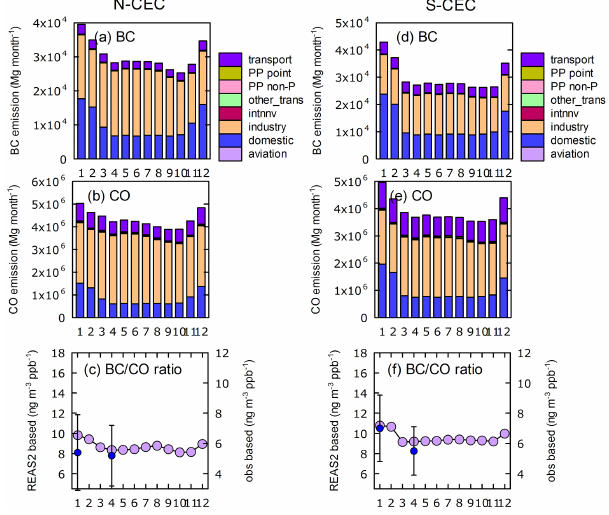
Figure 7. Monthly BC emissions from individual sectors for BC and CO and their ratios (purple) for (a–c) N-CEC (Beijing, Tianjin, Hebei, Shandong, and Shanxi) and (d–f) S-CEC (Shanghai, Anhui, Henan, Jiangsu, and Hubei) from REAS2 (Kurokawa et al., 2013). PP point and PP non-P are power plants identified as point sources and power plants included as non-point sources. In (c) and (f) , ob- served (cid:49) BC /(cid:49) CO ratios for DJF and MAM at Fukue for those air masses are plotted with blue dots with 1 σ